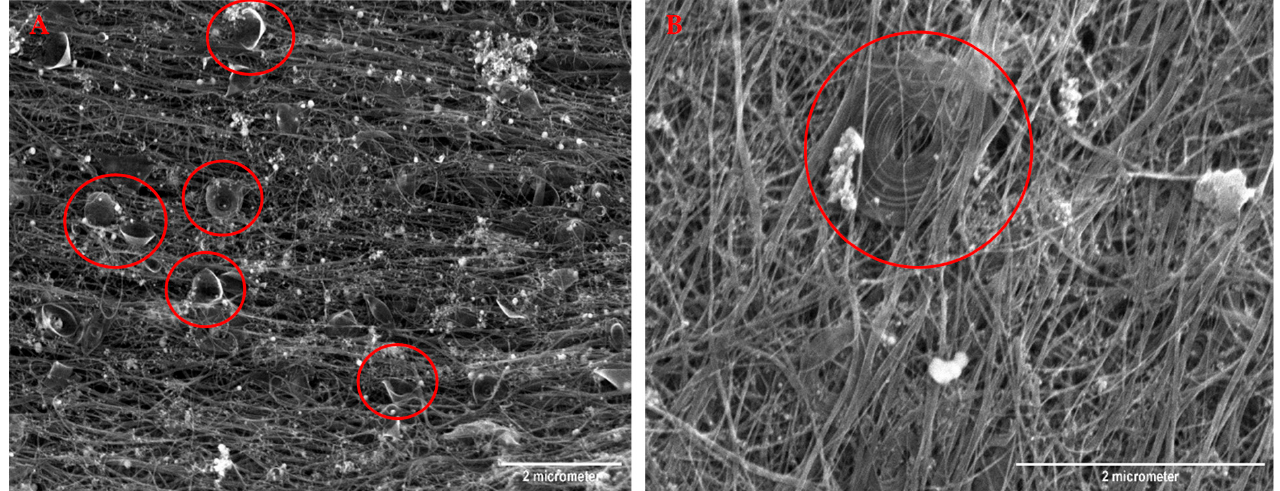
Figure 6. SEM images of CNT cones and spirals. ( A ) CNT cones in red circles. ( B ) Spiral CNT in the red circle.